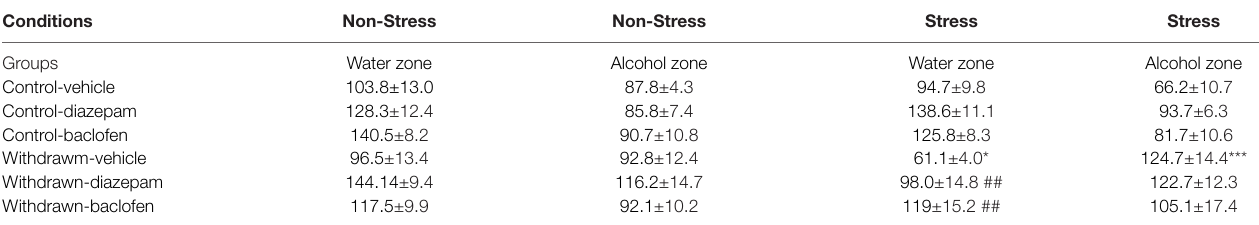
TABLE 2 | Time spent (in seconds) in the water and alcohol zones in withdrawn and control groups of Experiment 3. Data are expressed as means ± SEM. No significant difference was observed between groups on the time spent exploring the water zone in stressed or non-stressed water controls. In contrast, in the stress condition, vehicle-withdrawn mice spent more time exploring the alcohol zone and less time exploring the water one as compared to stressed vehicle-water controls (*** p < 0.001 and * p < 0.05, respectively). Stressed withdrawn diazepam and stressed withdrawn baclofen mice spent more time in exploring the water zone as compared to stressed withdrawn vehicles ( ## p < 0.01 in both